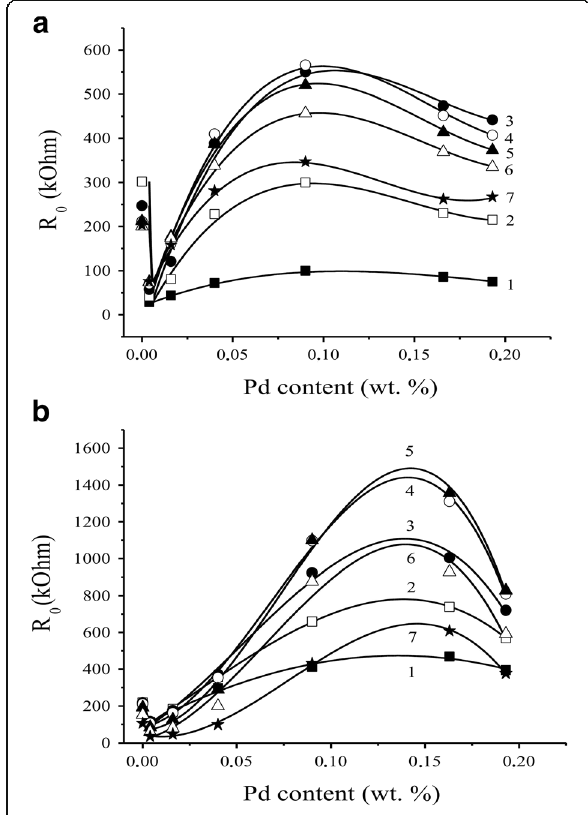
Fig. 4 Dependence of R 0 values of the sensors a S 1 and b S 2 based on Pd/SnO 2 on the palladium content at different temperatures of the sensors: 1 410 °C, 2 382 °C, 3 355 °C, 4 327 °C, 5 295 °C, 6 261